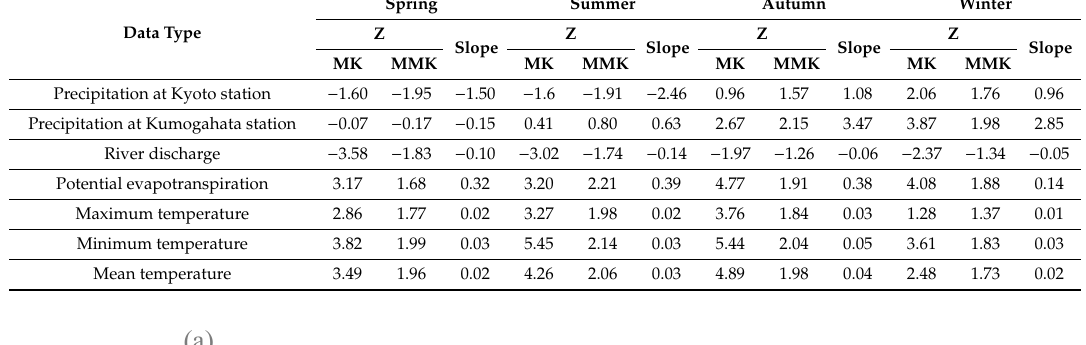
Table 3. Results of trend analysis in seasonal hydroclimatic variables from 1962 to 2017.